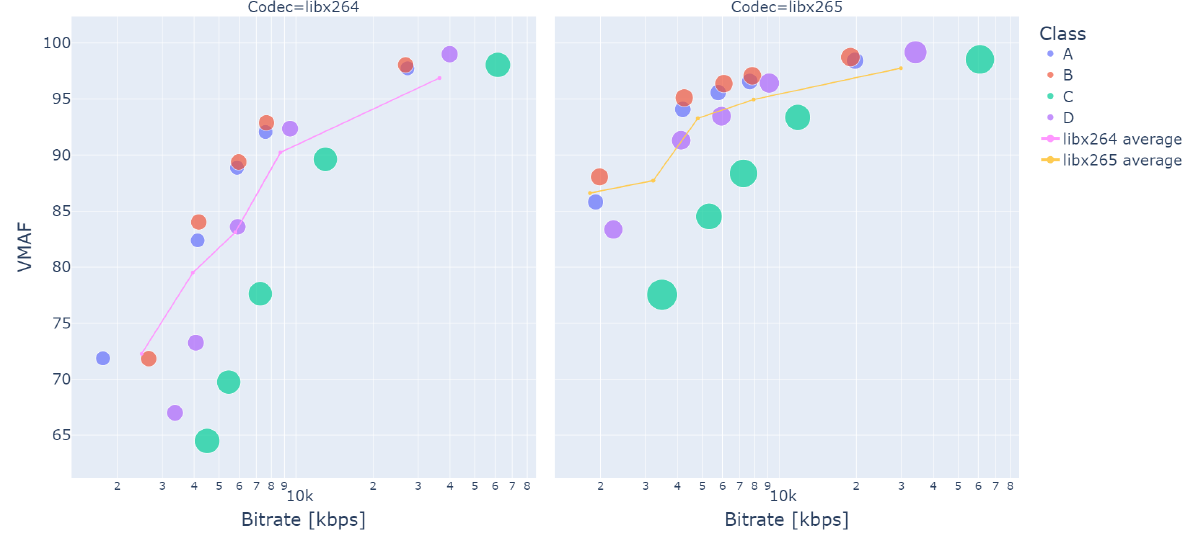
Figure 10. Classes A–D VMAF